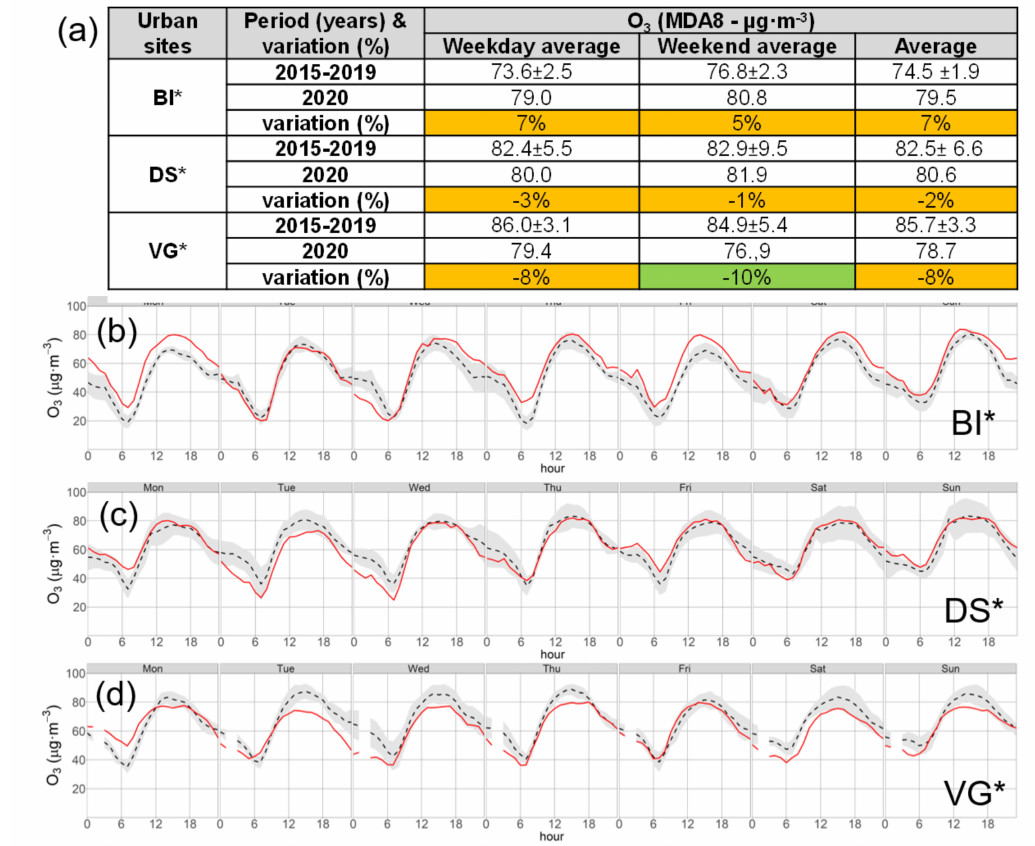
Figure 6. Daily maximum 8 − h average (MDA) O 3 values for weekdays, weekends, and the full period are shown in the table for the lockdown period and the corresponding years 2015–2019 in the three cities ( a ). The hourly averages of ozone during the mean week (Monday to Sunday) of the lockdown period are represented (solid red line) together with the corresponding inter-annual averages (dashed black line) and the standard deviations (gray shading) for BI* ( b ), DS* ( c ), and VG* ( d